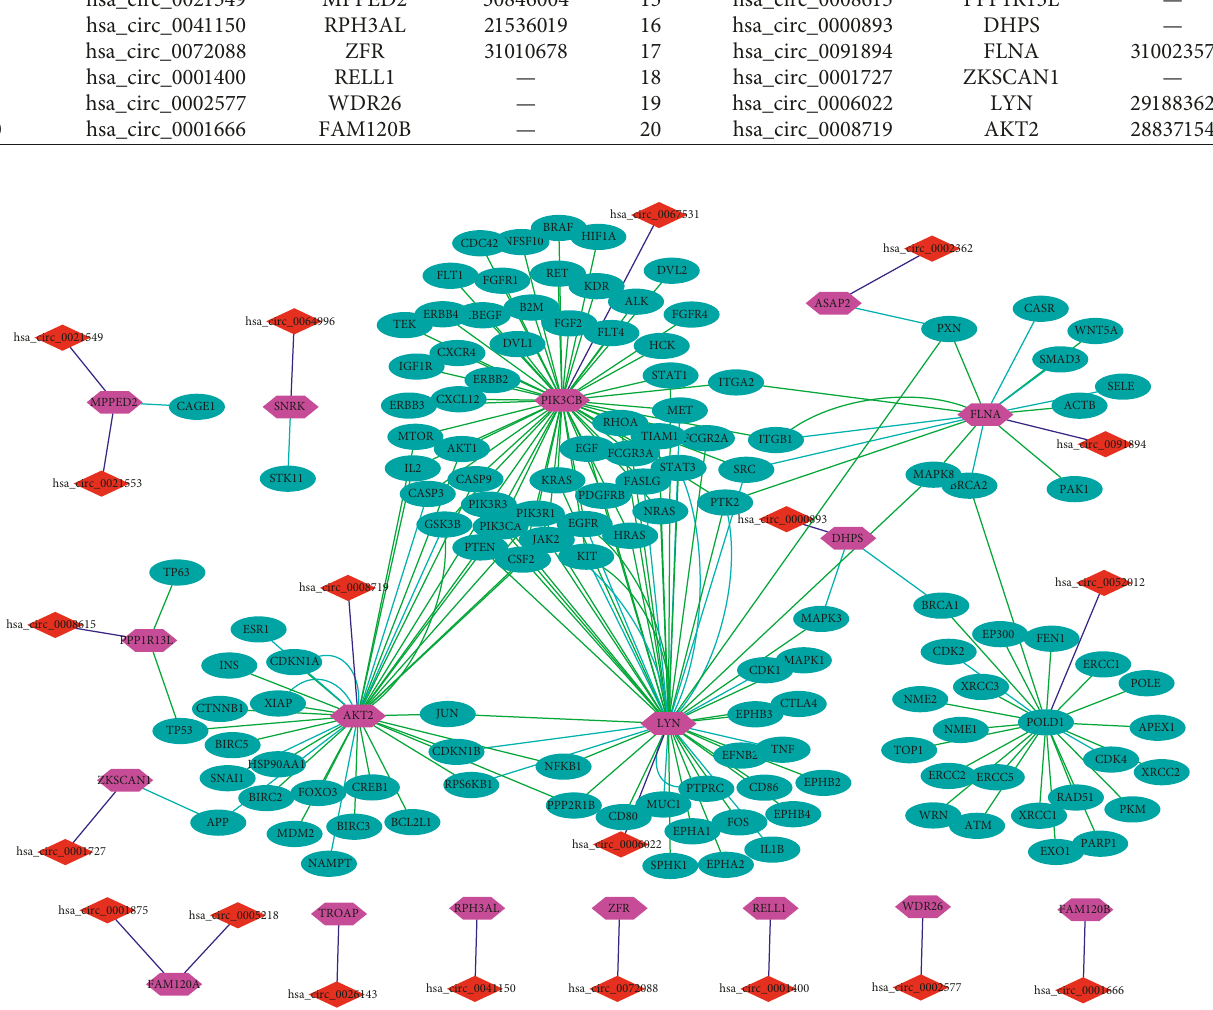
Figure 9: The interaction network method validated the top 20 results. Red nodes represent the circRNAs; pink nodes represent genes corresponding to circRNAs; dark turquoise nodes represent colorectal cancer genes; blue edges represent circRNA-gene associations; cyan edges represent protein-protein interactions; green edges represent Pathway